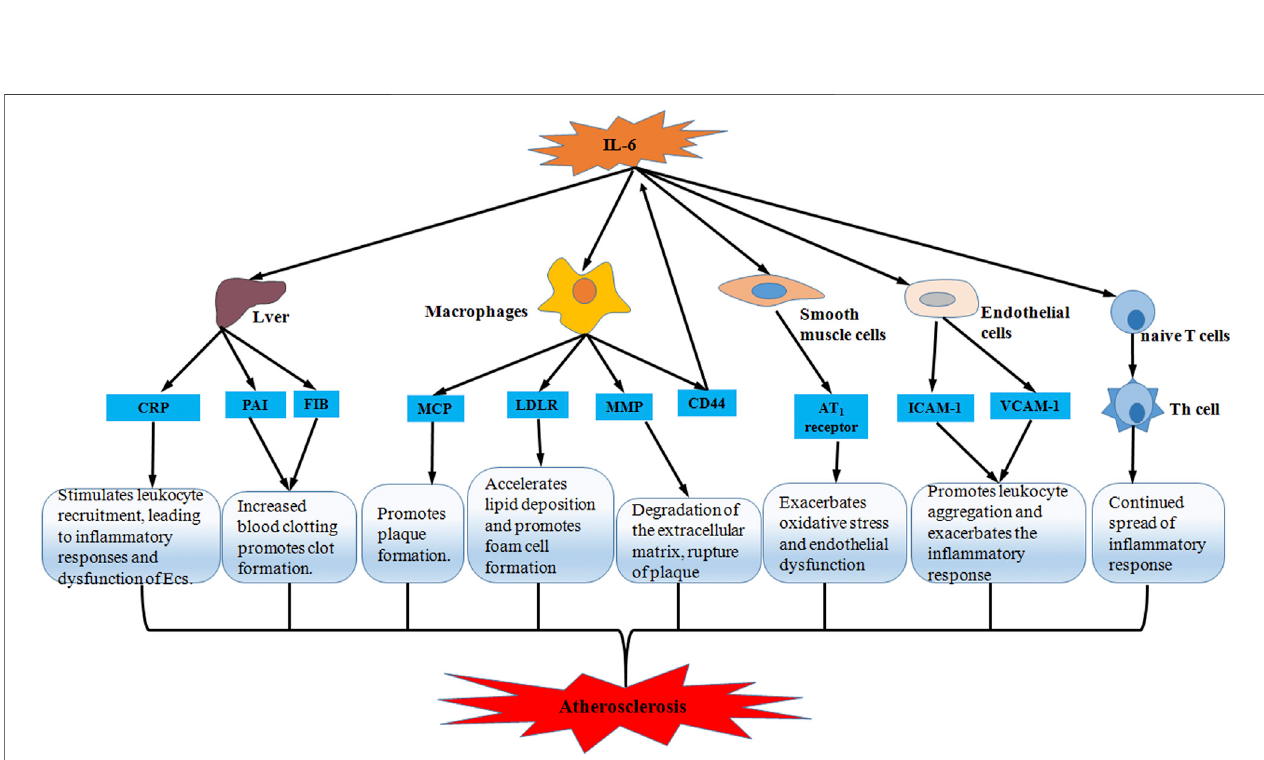
FIGURE 2 | Schematic representation of IL-6 accelerating atherosclerosis. Through fi ve pathways including liver, macrophages, smooth muscle cells, endothelial cells and T lymphocytes, IL-6 promotes in fl ammatory response and oxidative stress, and accelerates lipid deposition and foam cell formation, thereby participating in thrombosis and plaque formation and predisposing plaques to rupture. Ultimately, IL-6 exacerbates the progression of atherosclerosis.